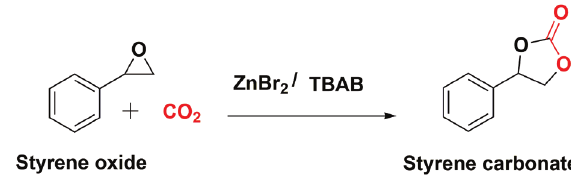
Figure 2: Styrene carbonate (SC) synthesis from styrene oxide (SO) and CO catalysed by ZnBr 2